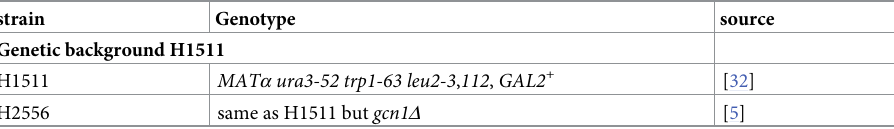
Table 1. Strains used in this study.